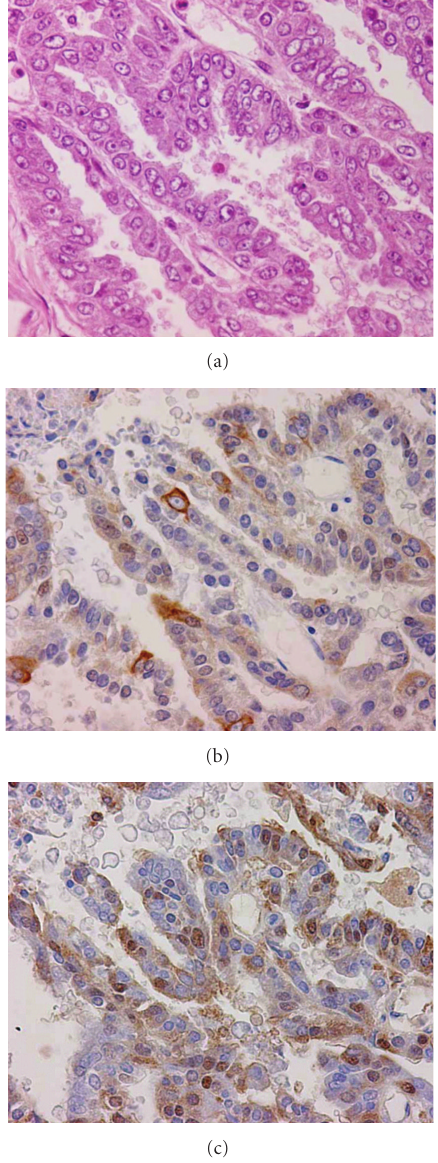
Figure 4: Papillary serous carcinoma of the peritoneum (PSCP). Neoplastic cells which ranged from cuboidal to columnar in shape with polygonal cytoplasm, proliferated and infiltrated in a papillary architecture, to the abdominal cavity and anterior thoracic wall (a). Human epidermal keratins (AE1/AE3) and progesterone receptor (PgR) are positive in (b) and (c),